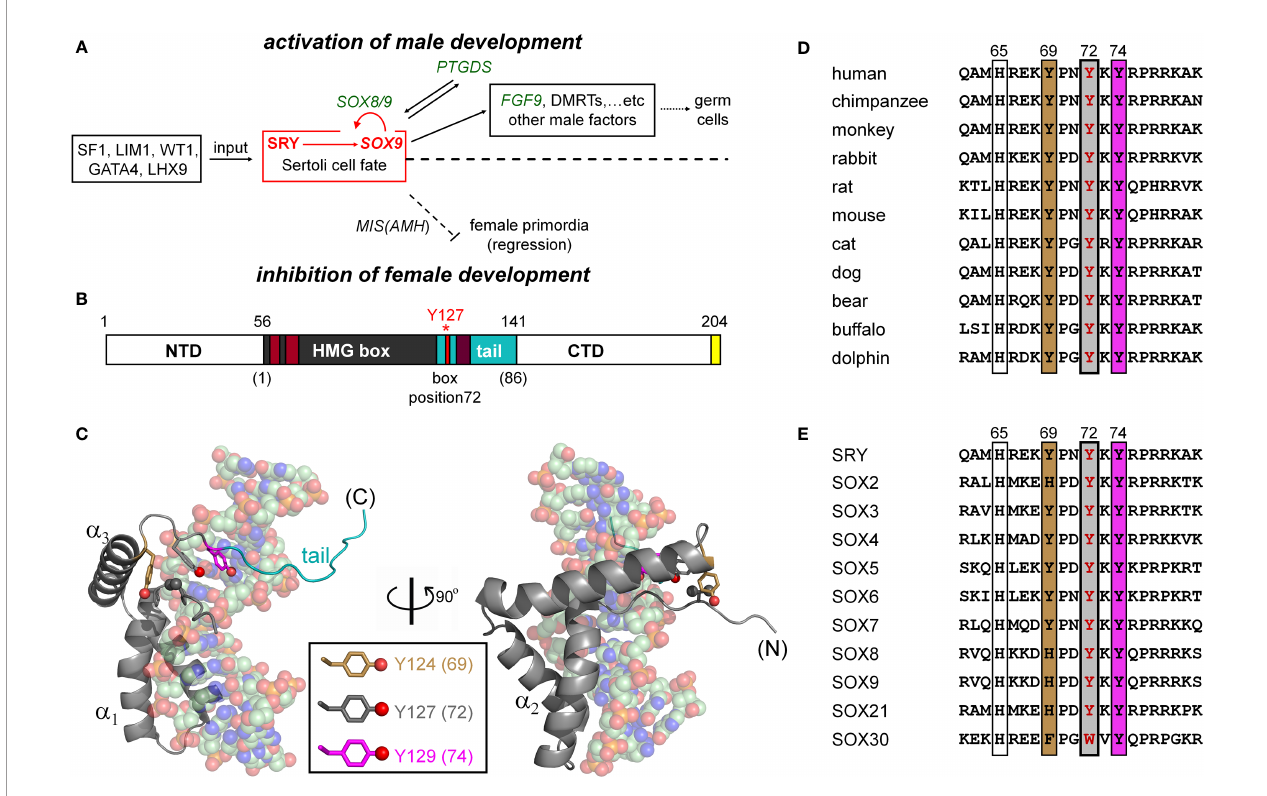
FIGURE 1 | SRY-regulated gene-regulatory network (GRN) and structure of SRY HMG box. (A) SRY-dependent testis determination pathway. Red box highlights central SRY ! SOX9 step (1, 2). Genetic inputs are at left and outputs at right. To effect gonadal-ridge differentiation, SOX9 activates a male-speci fi c GRN, in turn directing Müllerian- duct regression (dashed ⊥ ; Müllerian inhibiting substance MIS; also designated anti-Müllerian hormone (AMH)) (3) while inhibiting the granulosa-cell fate (1, 3). (B) SRY domain organization with HMG box in gray. The box ’ s basic tail (light blue) comprises residues 56-141. The extreme C terminus of SRY contains a PDZ-binding motif (yellow), proposed to interact with SIP-1 (4). Above bar are indicated residue numbers in intact SRY; red asterisk highlights Y127 (box position (5); see consensus numbering scheme below bar. Nuclear localization signals N-NLS and C-NLS are respectively highlighted in light- and dark brown (6). (C) Solution structure of SRY box-DNA complex (Protein Databank entry 1J46) (7). The HMG box (ribbon; basic tail in light blue) docks within minor groove of bent DNA site (space- fi lling). The domain contains major- and minor wings, the latter comprises the N-terminal b -strand, the remainder of a -helix 3, and C-terminal tail. The minor wing is stabilized by an “ aromatic box ” in a mini-core containing the side chains of V60, H120, Y124, and Y127, extended by Y129 at tail-DNA interface (respective box positions 5, 65, 69, 72 and 74; parentheses). The three Tyr side chains (inset color code; residues) exhibit distinct structural environments. For clarity, the view at right re fl ects a 90° rotation about the vertical axis. (D) Sequence alignment among selected mammalian orthologs highlighting box residues 62-81. Conserved residues at positions 69, 72, and 74 are outlined. Gray-shaded box indicates position of the clinical variants characterized in the present study (Y127 in intact human SRY); fi lling colors as in (C) . (E) Corresponding alignment of human SOX homologs